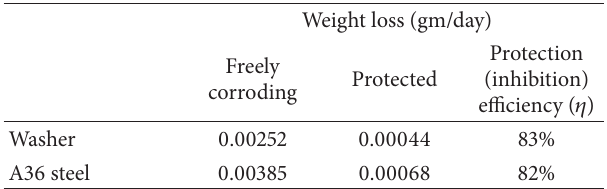
Table 2: The weight loss per day for the freely corroding and the protected washer and A36 steel sample in the 0.6 M NaCl